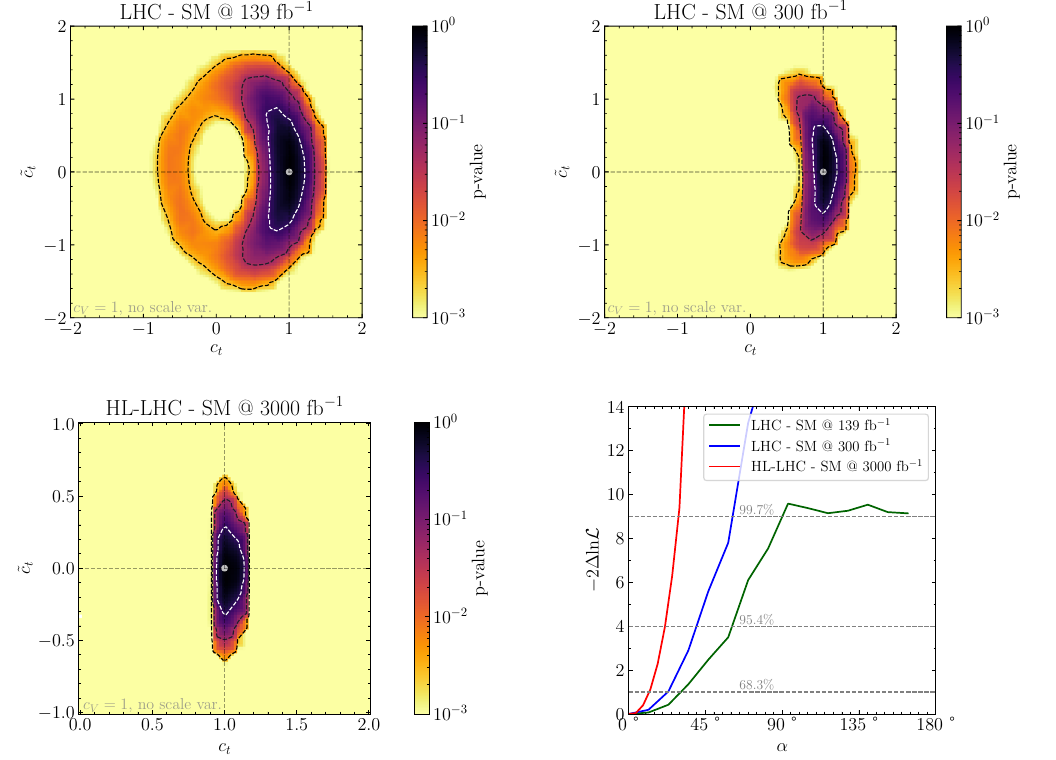
Figure 4 . Upper left: expected limits (assuming SM data) on c t and ˜ c t using a luminosity of 139 fb − 1 . We assume that c V = 1 and do not vary the renormalization scale. Upper right: same as upper left panel but for a luminosity of 300 fb − 1 . Bottom left: same as upper left panel, but the constraints are evaluated for the HL-LHC with a luminosity of 3000 fb − 1 . Bottom right: constraints on the CP -violating phase α for a luminosity of 139 fb − 1 (green), 300 fb − 1 (blue), and 3000 fb − 1 (red) after profiling of | g t |